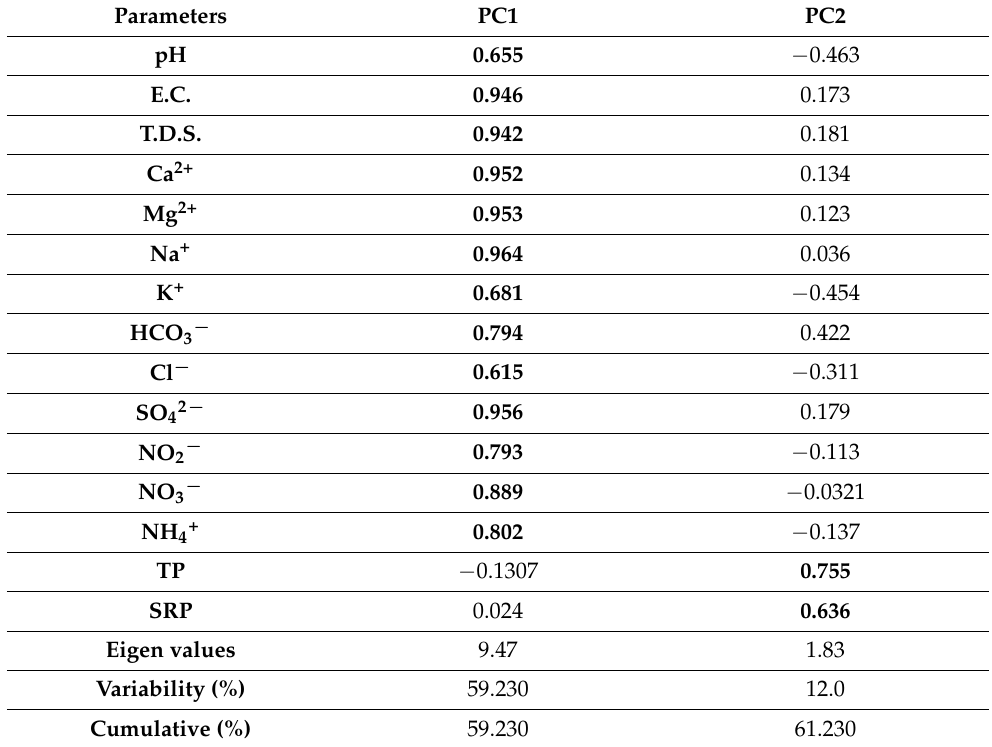
Table 6. Principal component analysis (PCA) and loadings of the water quality parameters for the entire